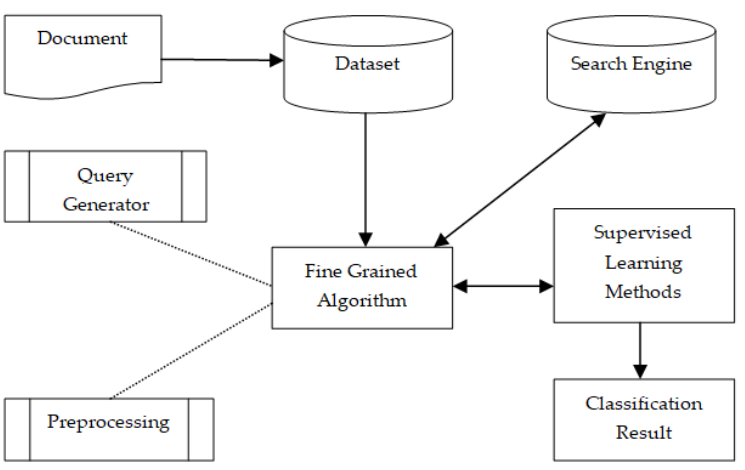
Figure 1. Framework of process improving KNN computational performance.